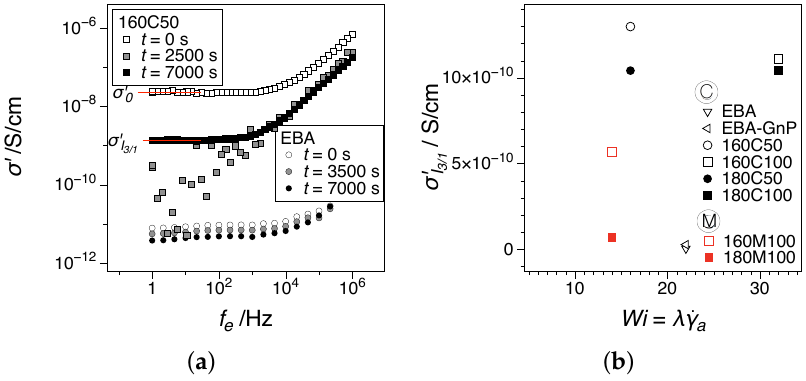
Figure 12. Electrical conductivity as the plateau at low frequencies of the real part of the complex dielectric conductivity [46], σ (cid:48) , for the samples under investigation: ( a ) examples of the transient dependence and ( b ) conductivity at the onset of I 3/1 steady variation as a function of the processing (die) Weissenberg number, Wi